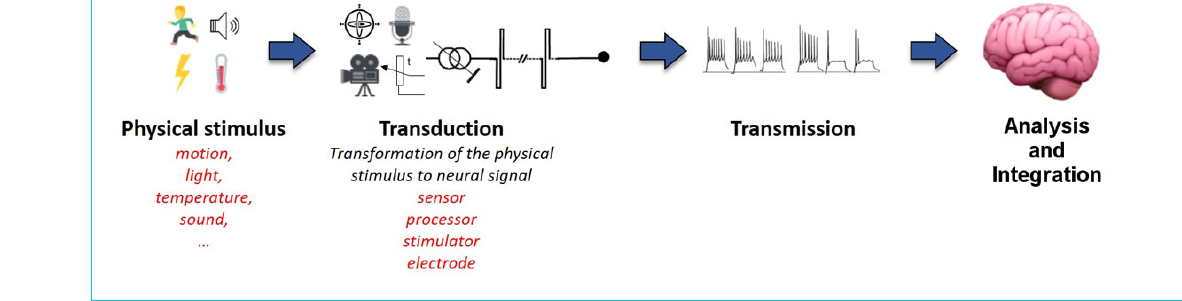
Figure 3: The “artificial senses ”. When the sensory deficit is due to damage to the peripheral receptor, it can be replaced by external and im- planted electronic components (sensor, processor, stimulator, electrodes in the vicinity of the sensory afferent). The concept is to transform the physical stimulus into a pattern of electrical currents that is consistent with the fundamental organization of the sensory